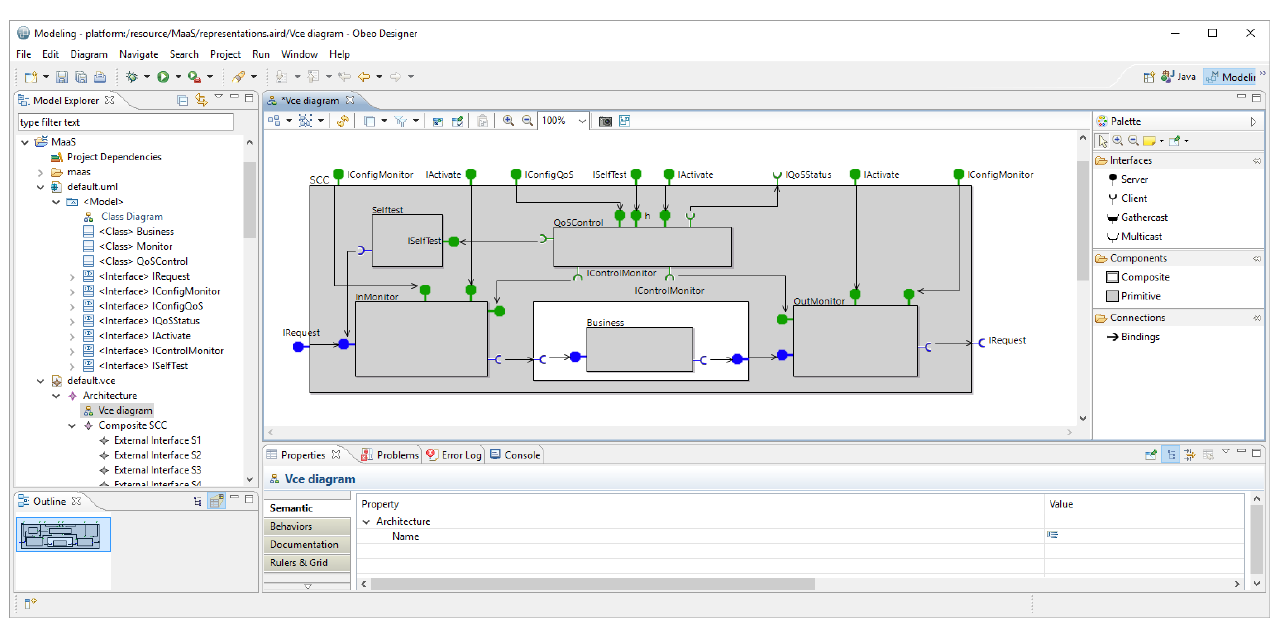
Figure 3. VerCors Component